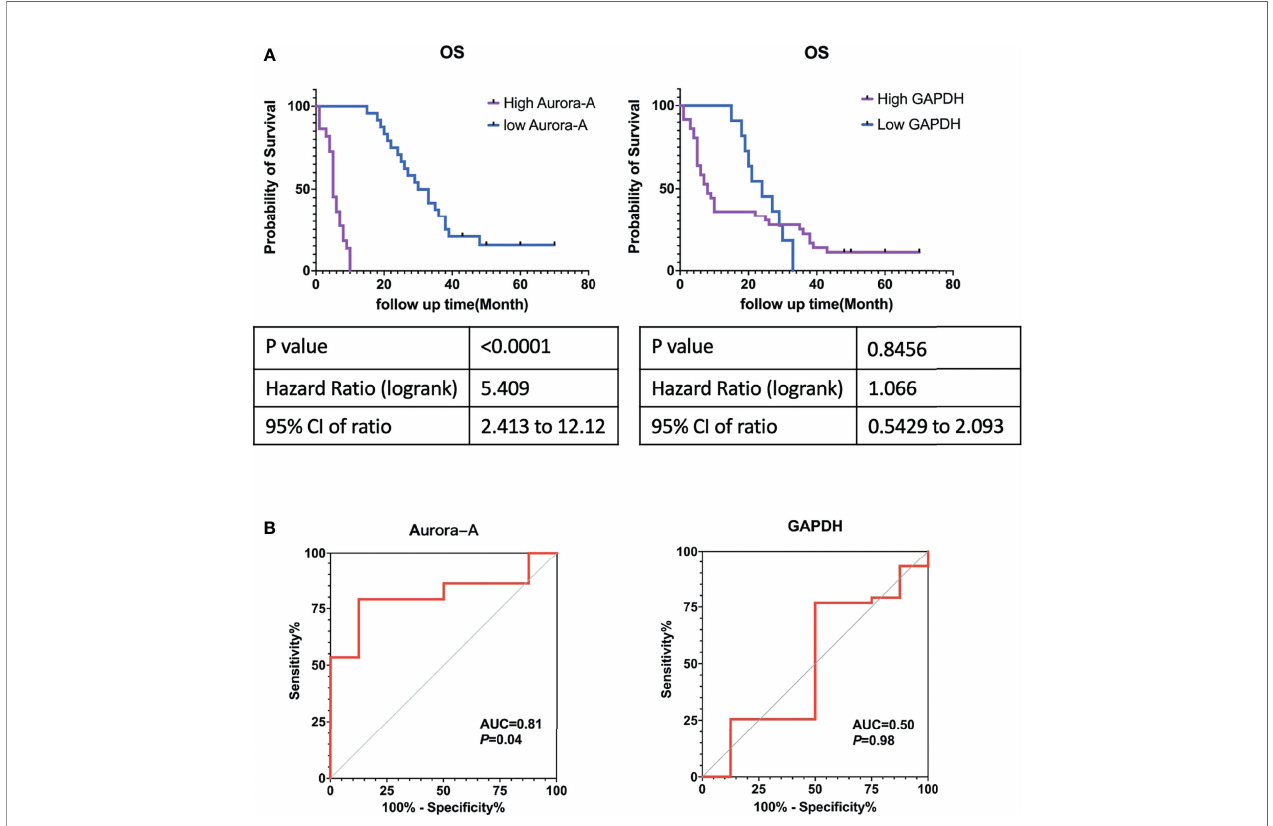
FIGURE 6 | Aurora-A and GAPDH protein expression in tissue microarrays from patients with malignant mesothelioma. (A) Kaplan-Meier survival curves. (B) Receiver operating